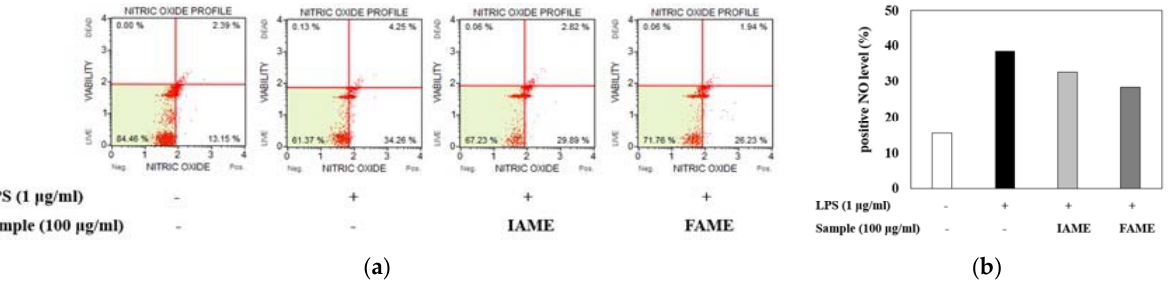
Figure 5. Effects of IAME and FAME on nitric oxide (NO) production in lipopolysaccharide (LPS) ‐ stimulated Raw264.7 cells. ( a ) Quantitative measurements of NO production were performed via cytometry, using the Muse Nitric Oxide kit. Raw264.7 cells were pretreated with IAME and FAME (100 μ g/mL) for 2 h and then stimulated with LPS (1 μ g/mL) for 20 h. ( b ) The graph shows the NO percent positivity. IAME, Abelmoschus manihot extract; FAME, A. manihot extract fermented by Ba ‐ cillus licheniformis CP6.